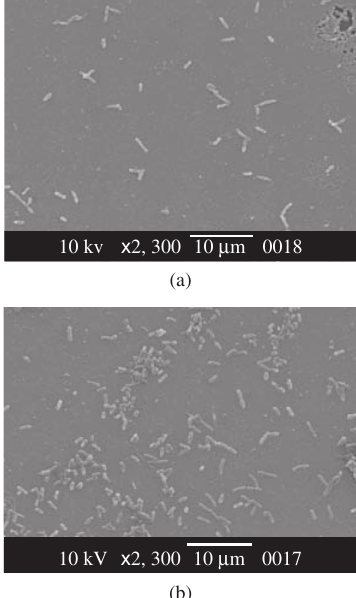
Figure 3. a) SEM microphotograph of cristalline Cu surface exposed during 30 minutes to a P. fluorescens culture; and b) SEM microphotograph of cristal- line Au surface exposed during 30 minutes to a P. fluorescens